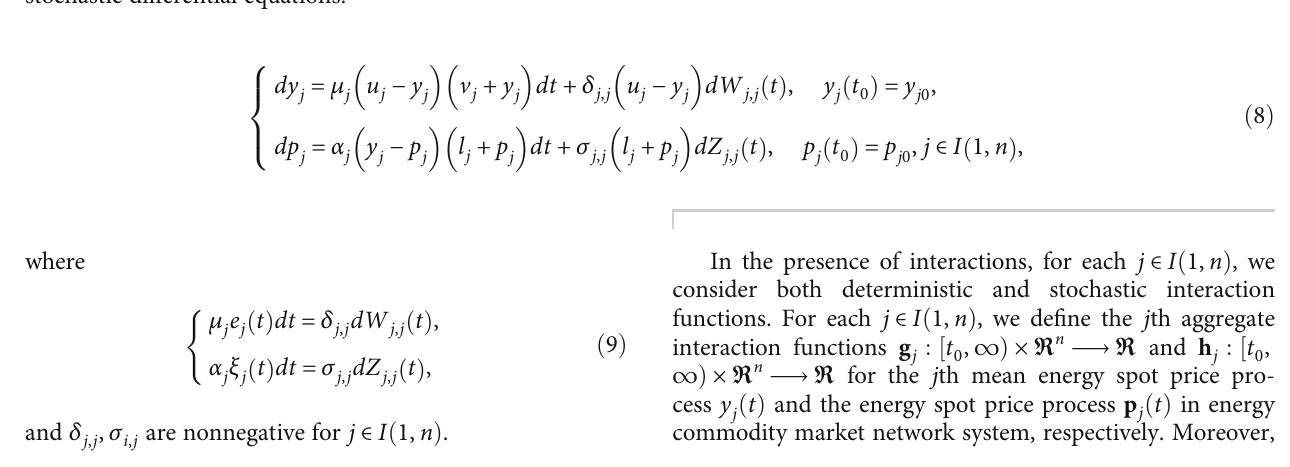
Figure 6: The graph of σ natural gas, crude oil, and coal,